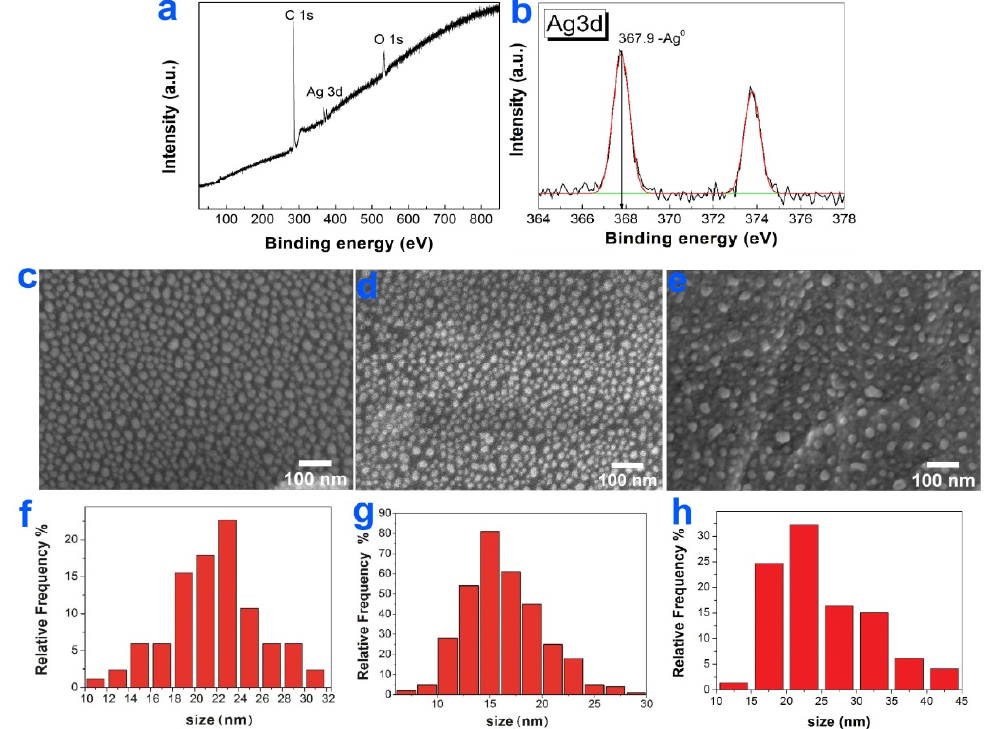
Figure 8. XPS spectra of Ag/ СС M with fitting of C1s, O1s ( a ), fitting of Ag3d spectra ( b ), SEM images of Ag/ СС M ( c ), Ag/CFR-PEEK ( d ) and Ag/Pt/CFR-PEEK ( e ) with AgNP size distributions Ag/ СС M ( f ), Ag/CFR-PEEK ( g ) and Ag/Pt/CFR-PEEK ( h ). AgNPs with a unimodal distribution with sizes 18–24 and 13–20 nm, respectively, were formed on the surface of CCM and CFR-PEEK discs (Figure 8c,d). On the surface of Ir, Pt and PtIr films, AgNPs were enlarged and merged into clusters as large as 200 nm. In particular, AgNPs with sizes of 15–25 nm and Ag clusters (30–45 nm) were formed on